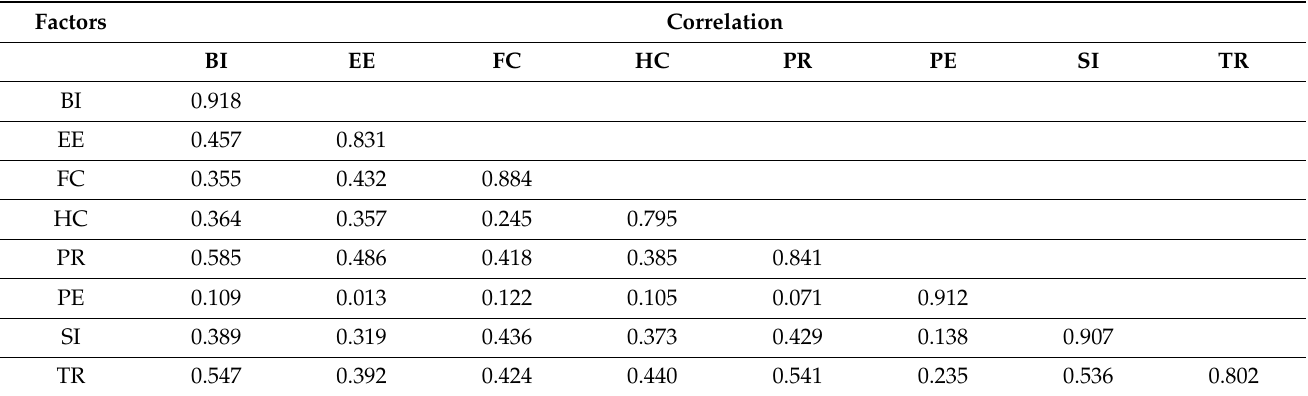
Table 3. Correlation matrix after removing non-conforming items.